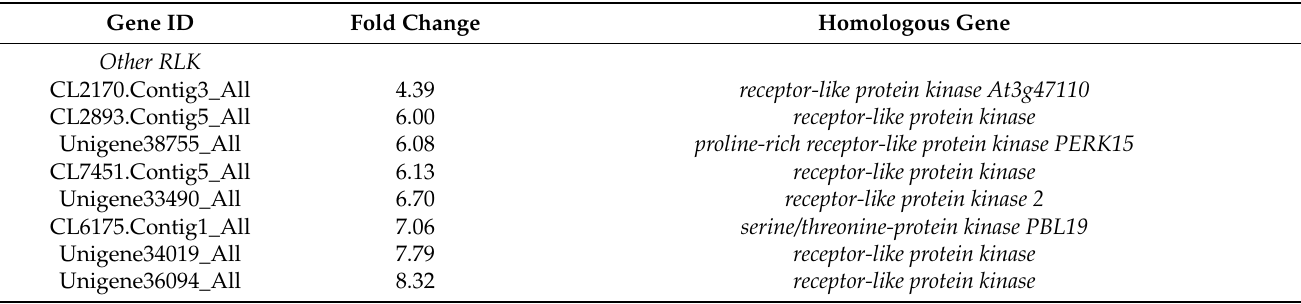
Table 13. The upregulated DEGs related to protein kinases in the leaves of A. canescens under 100 mM NaCl, but not under control conditions, for 6